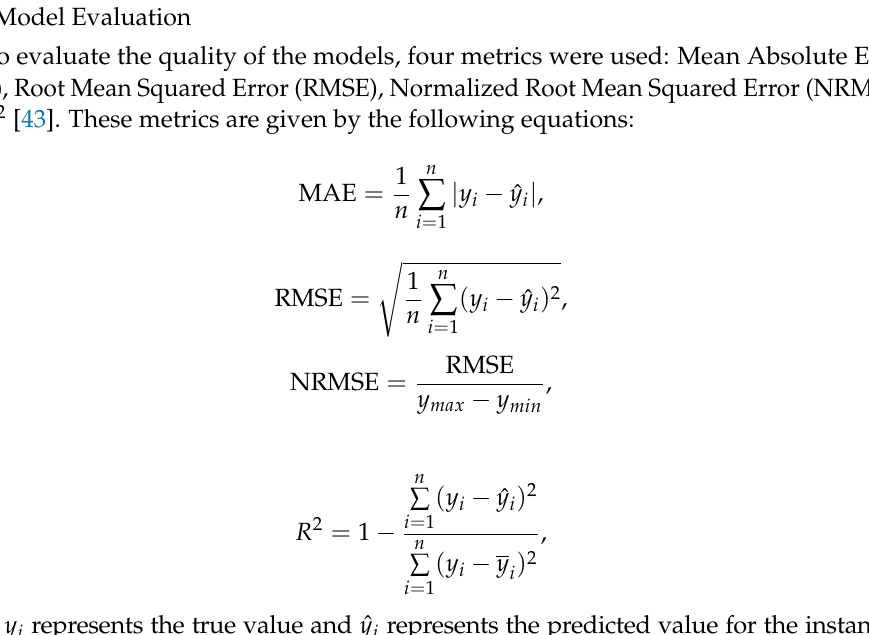
Figure 10. The first process to define the best algorithm. First, dataset A was split into two parts: training and testing. Second, the models were trained: three different models, one for each target variable— x , y and θ . Finally, the test was executed for each model, and the error measurements were